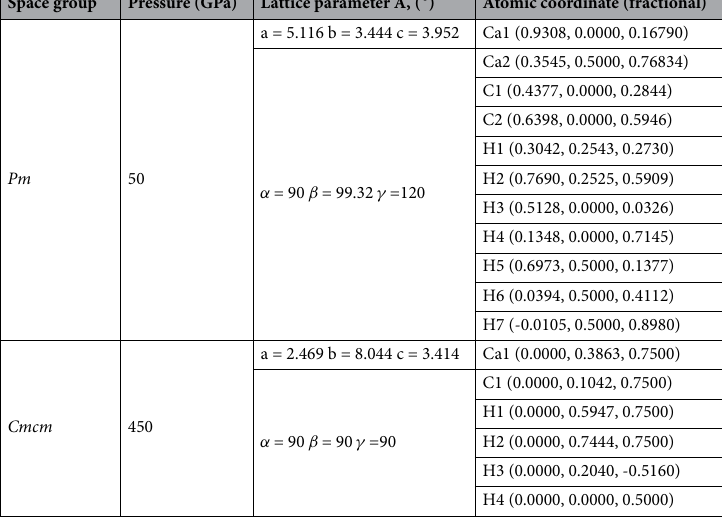
Table 1. Structures of CaCH 5